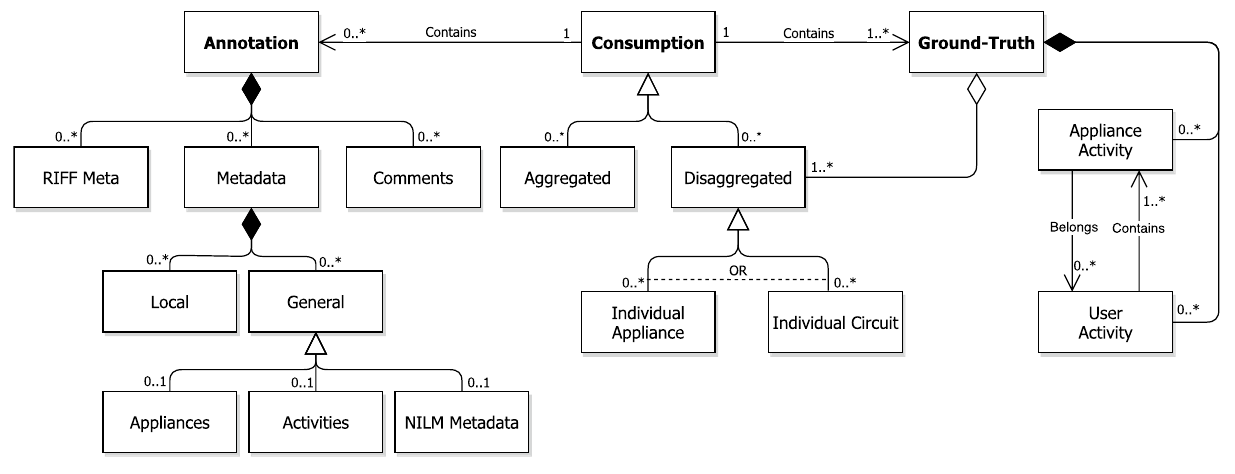
Figure 1. EMD-DF64: Data model